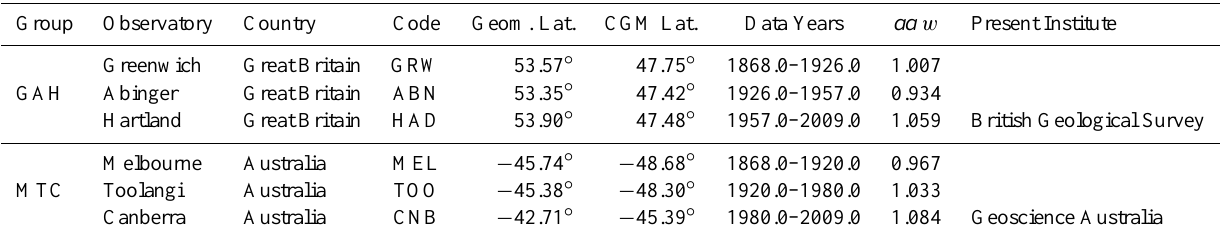
Table 1. Summary of observatories for which K index and aa index values are used; w denotes the weighting factors used for making adjustments of a -data for the construction of aa . Geomagntic and corrected geomagnetic (CGM) latitudes, given for qualitative comparison, are for 2008.0. Geom. Lat.